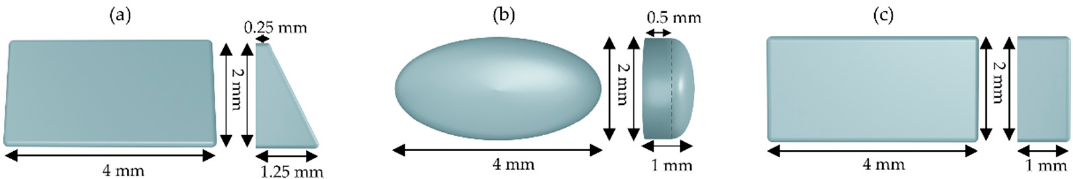
Figure 2. Dimensions of the ( a ) rectangular beveled attachment, ( b ) ellipsoid attachment, and ( c ) horizontal rectangular attachment [9].